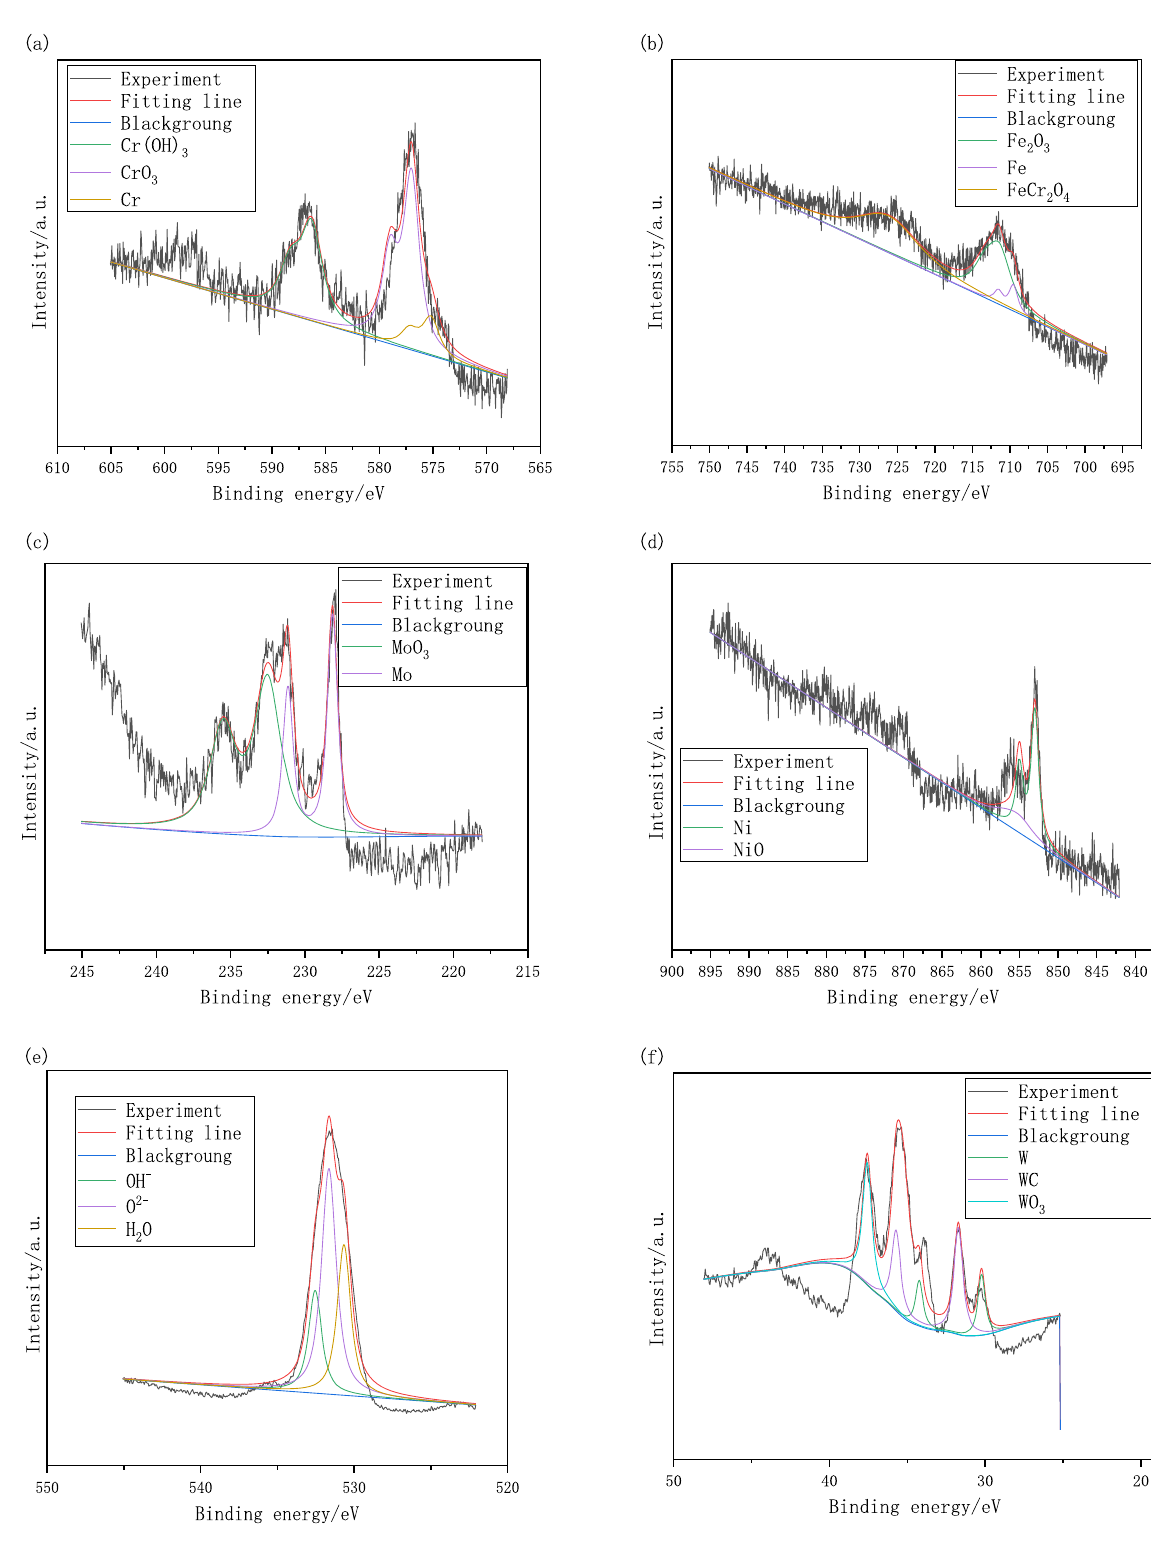
Figure 11: Cr ( a ) , Fe ( b ) , Mo ( c ) , Ni ( d ) , O ( e ) and W ( f ) high resolution XPS spectra of passive fi lm of Ni + 15% WC coating exposed to 3.5 wt% NaCl solution for 30